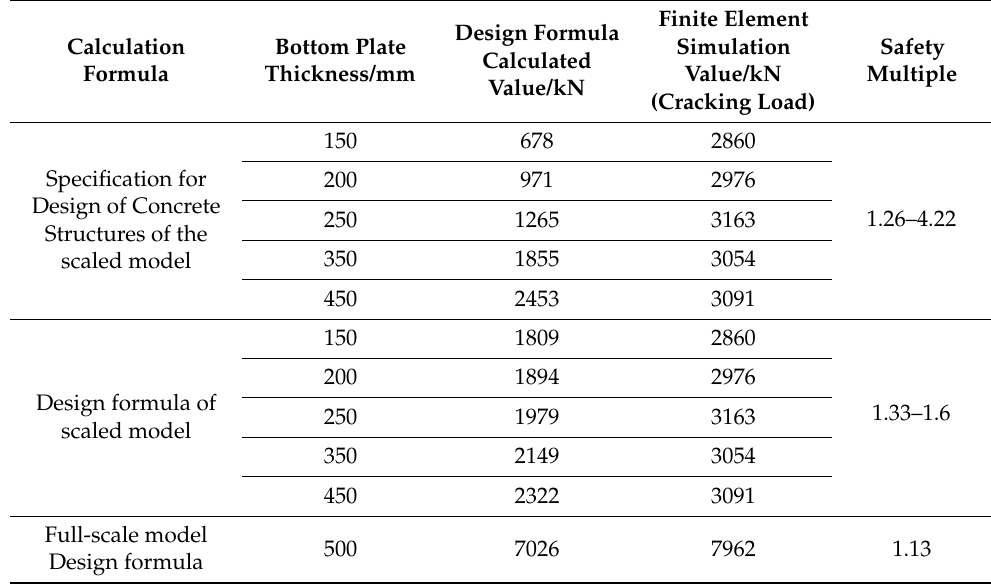
Table 6. Summary of calculation